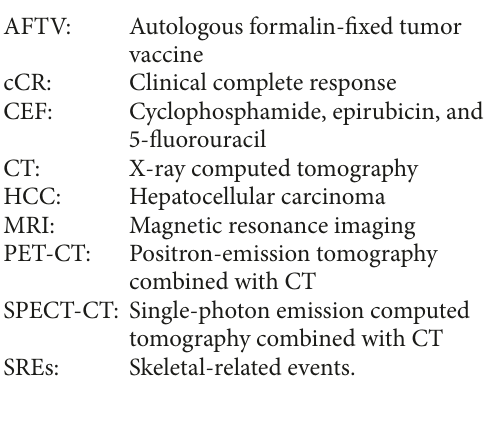
Supplementary Materials Supplementary Table: peripheral blood cell counts in breast cancer patients before and after the first course of AFTV vaccination. (Supplementary